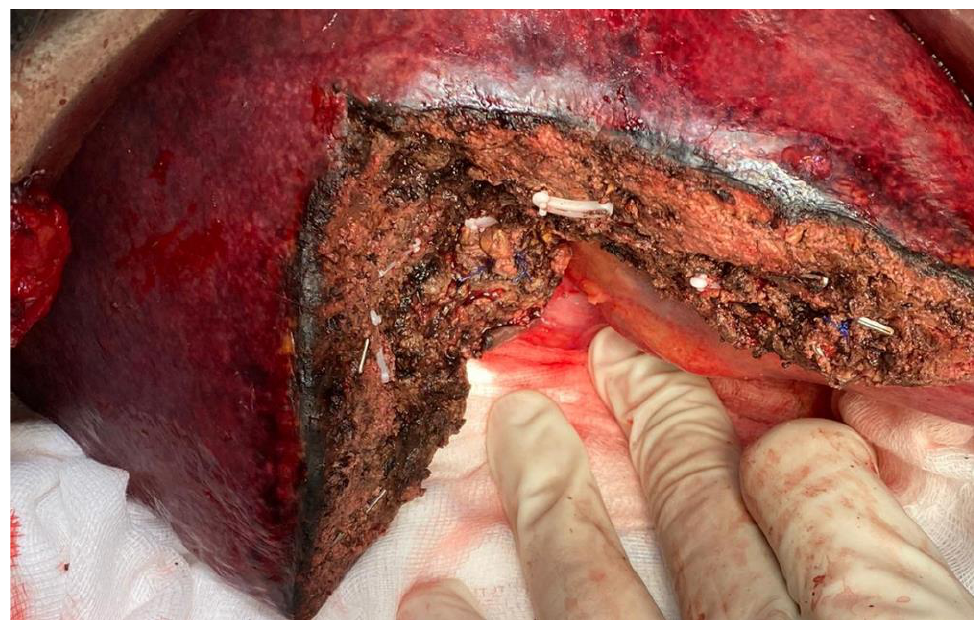
Figure 1. Anatomical bisegmentectomy of VI-VII in patient with metastases from kidney cancer.